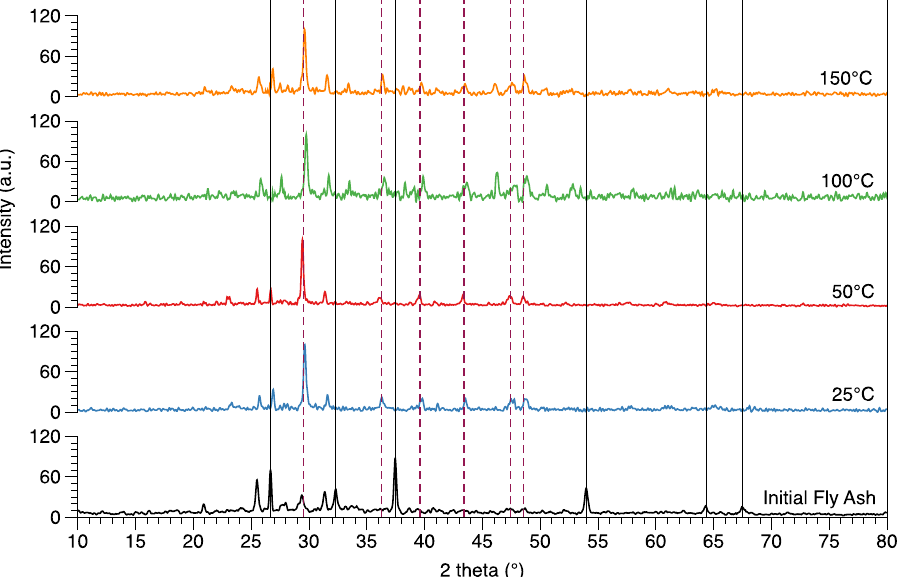
Figure 3. XRD patterns of fly ash carbonation products.